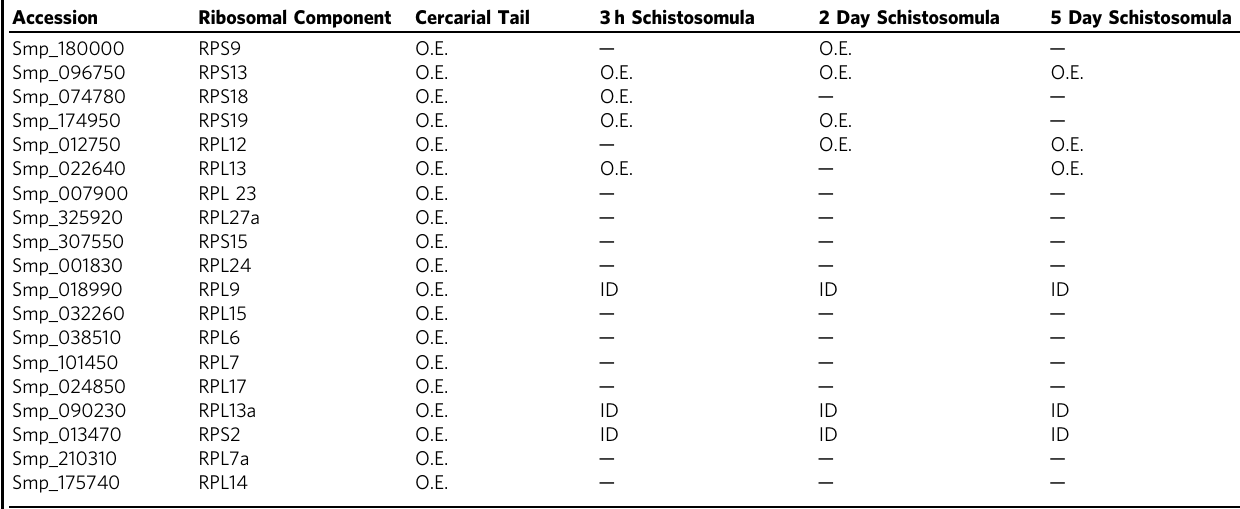
Table 1 Over-expressed (O.E.) ribosomal component proteins in cercarial tails. Accession Ribosomal Component Cercarial